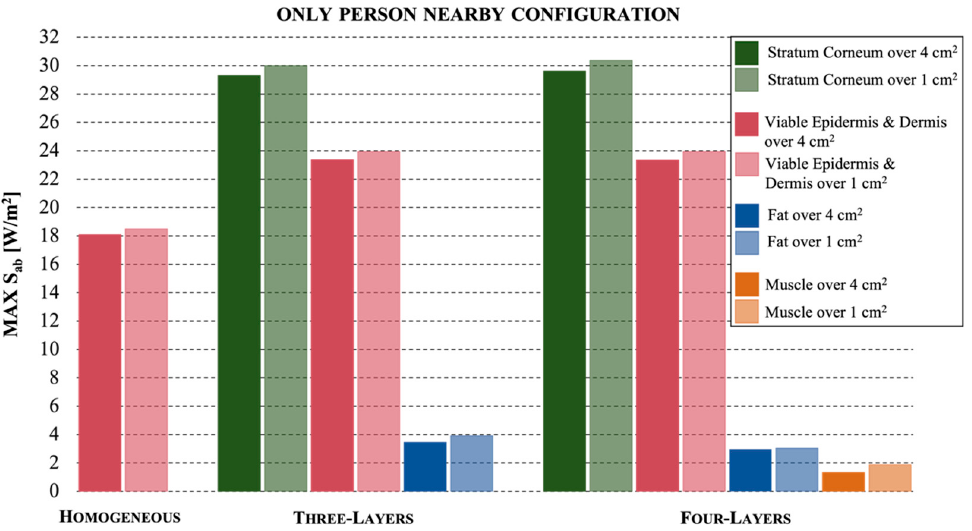
Figure 4. The maximum values of absorbed power density for the configuration where there is a person in the proximity of the mobile phone with a distance of 25 cm, for the three different skin models.